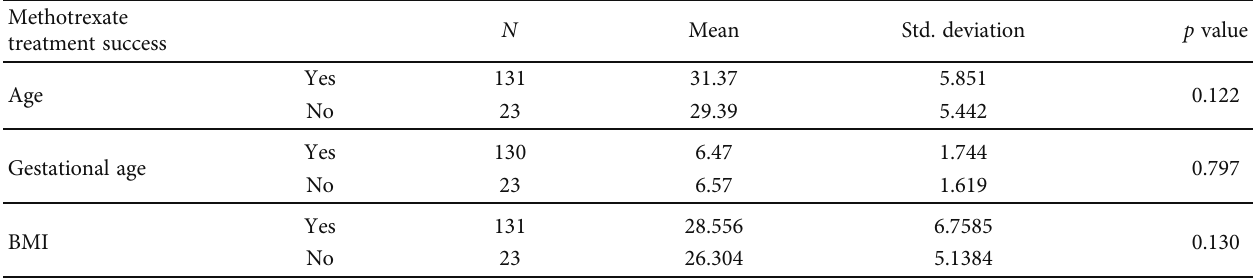
Table 1: Demographic characteristics.